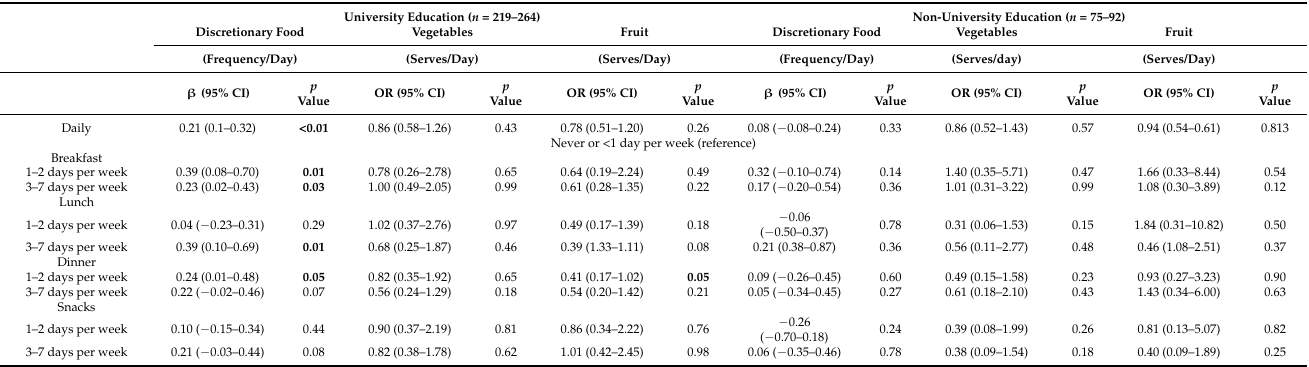
Table A2. Stratified analysis by parental education—Associations between children’s mealtime TV use at baseline and consuming two or more serves of fruit and vegetables per day, and consuming non-core discretionary foods on more than one occasion per day at the follow-up, adjusting for baseline intakes and